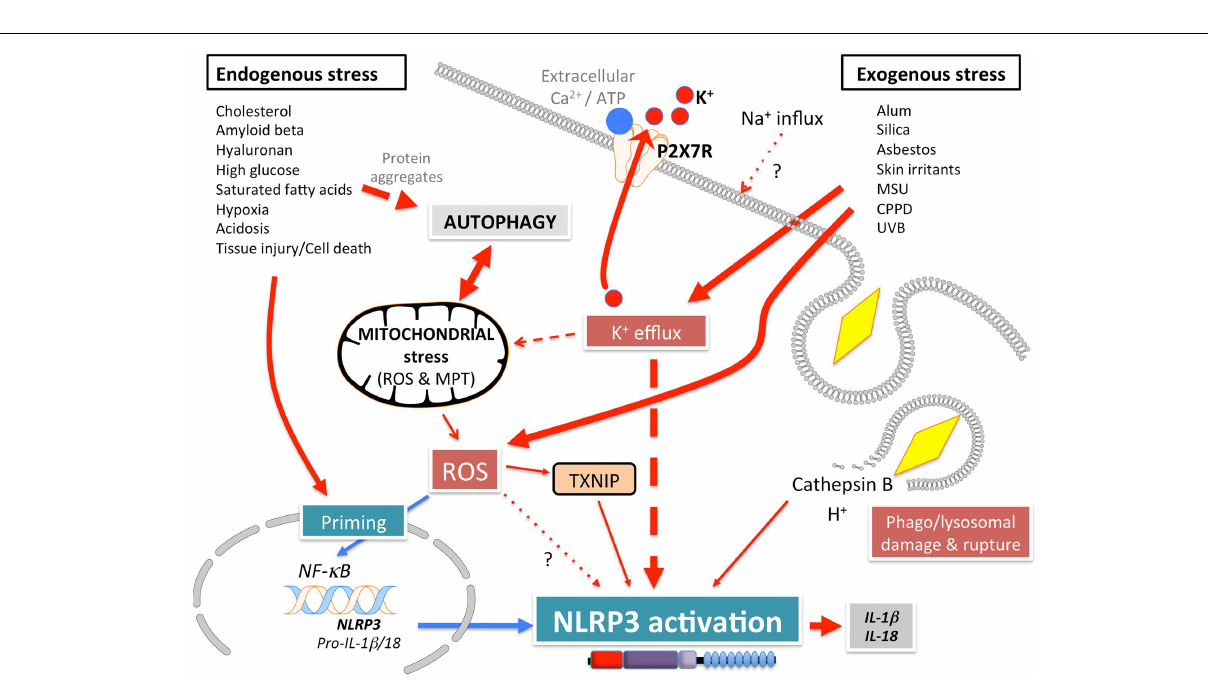
FIGURE 4 | Mechanism of NLRP3 activation in response to endogenous and exogenous danger signals